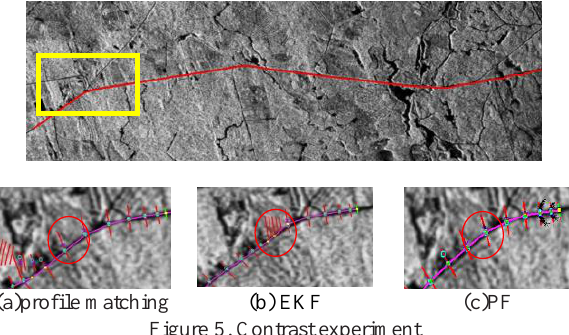
Figure 5. Contrast